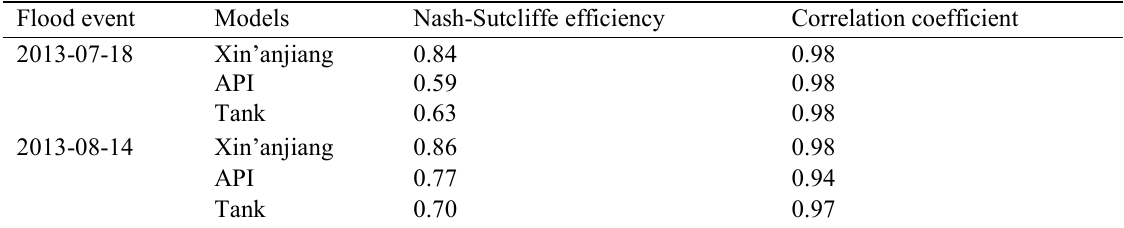
Table 2 Models performances for selected flood